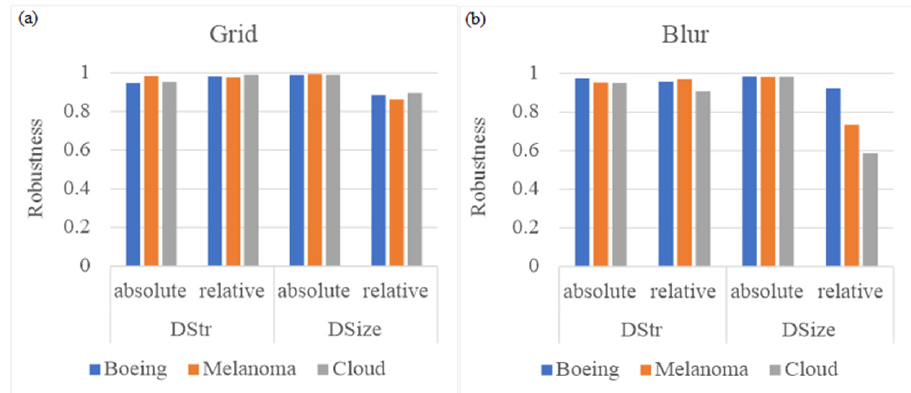
Figure 6. Absolute and relative robustness of DStr and DSize of contour maps. ( a ) Robustness of DStr and DSize against grid size. ( b ) Robustness of DStr and DSize against Gaussian blur of grayscale images.